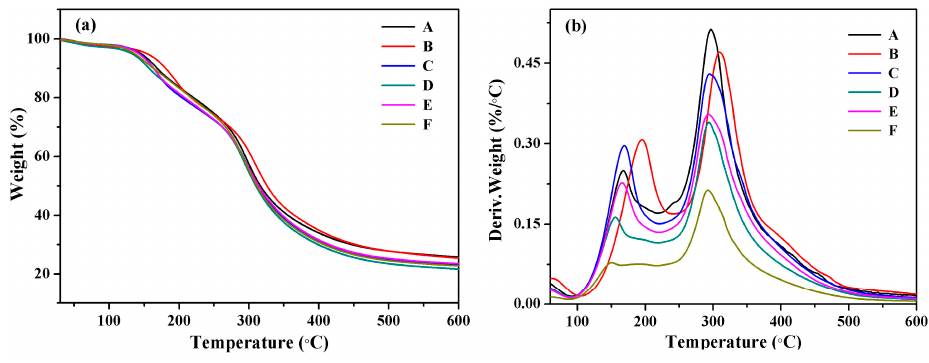
Figure 6. ( a ) The thermo gravimetric (TG) and ( b ) derivative TG (DTG) curves of SPI-based films. Table 2. TG parameters for the thermal degradation of SPI-based films.